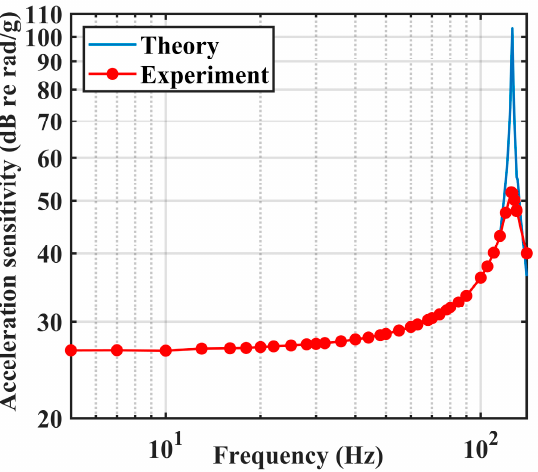
Figure 8. Acceleration sensitivity curve of the planar cantilever in air.